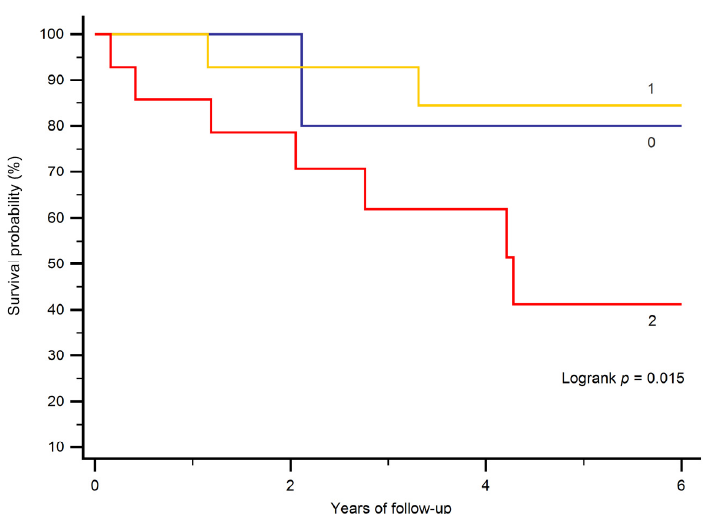
Figure 1. Kaplan–Meier curves stratifying patients according to the presence of laboratory results above or below the cut-off value for NT-proBNP and creatinine. 0 indicates that neither was above the cut-off value, 1 indicates that one (either NT-proBNP or creatinine) was above its respective cut-off value, and 2 indicates that both were above the respective cut-off values.